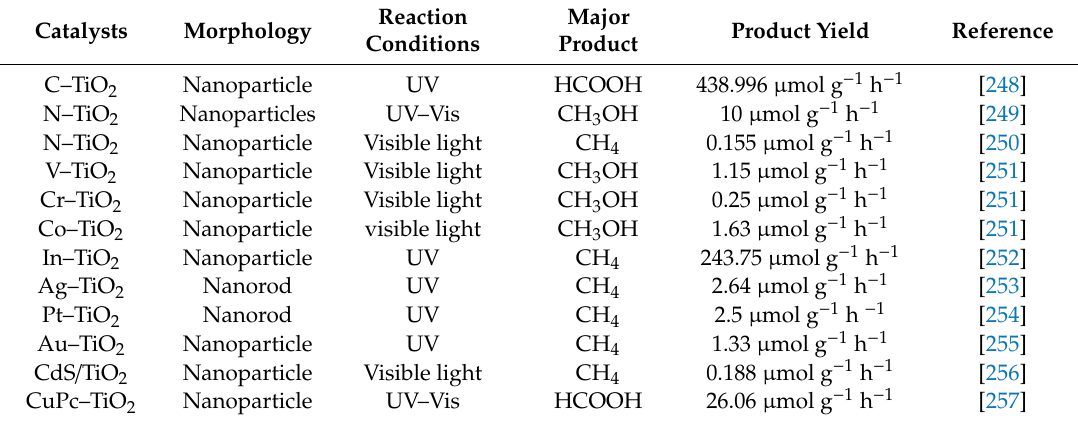
Table 3. Summary of common methods to improve the photocatalytic reduction of the carbon dioxide activity of TiO 2